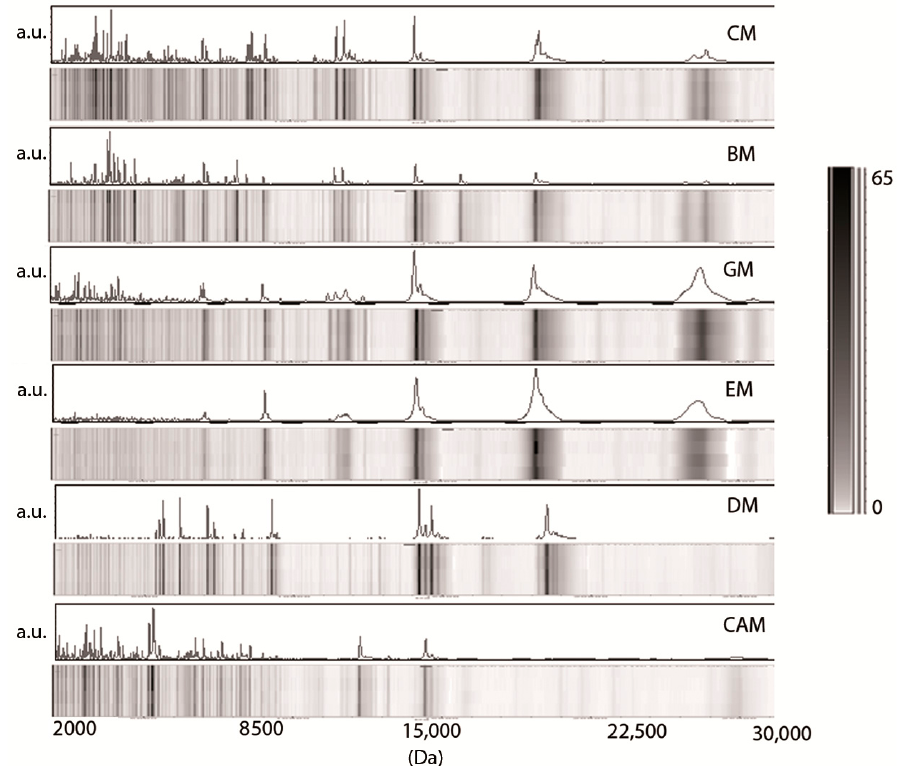
Figure 3. Representative MALDI TOF MS profiling and pseudogel view of crude milk from cow milk (CM), buffalo milk (BM), goat milk (GM), ewe milk (EM), donkey milk (DM), and camel milk (CAM). The mass-to-change ratios ( m / z ) are reported on the X axis (Da), while the peak intensities are indicated as arbitrary units (a.u.) in the gray scale bar on the Y axis.